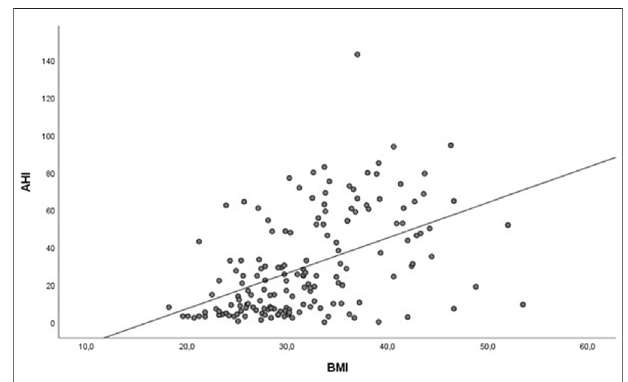
FIGURE 1 | Correlation between AHI and BMI